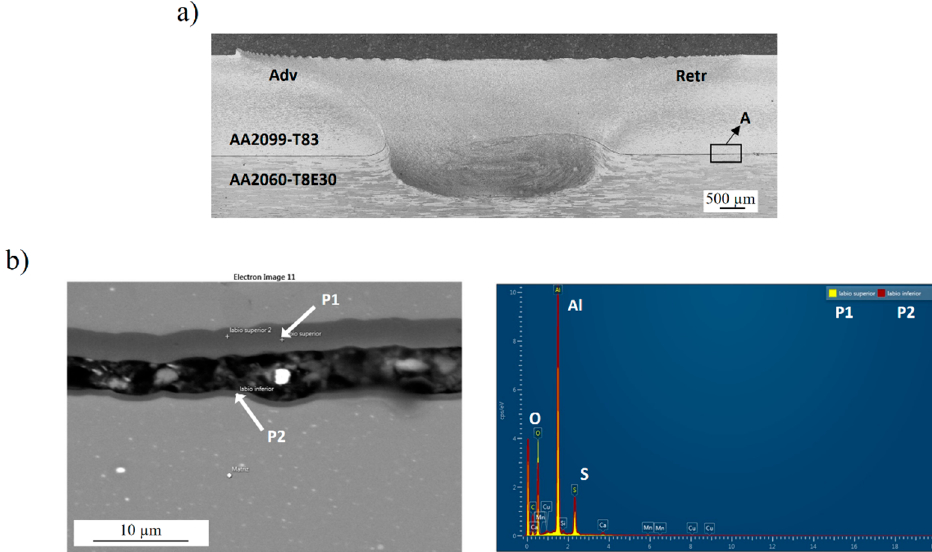
Figure 8. ( a ) Cross-sectional macrograph of the FSW weld from coupon C2 and ( b ) SEM image of the region indicated as detail A in Figure 8a (left) and EDS analysis (right) of points P1 and P2 shown in Figure 8b.